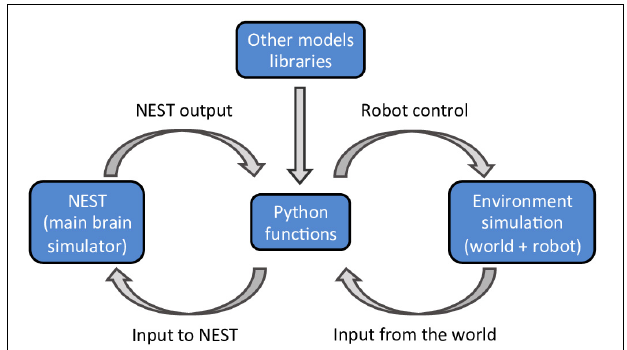
FIGURE 1 | A schematic outline of the NRP components. The platform can simulate a virtual environment (right) and a NEST brain model (left). Interactions between the brain and the virtual environment are set in python functions (center). These functions also take care of models that are not simulated in NEST, importing the required libraries as python